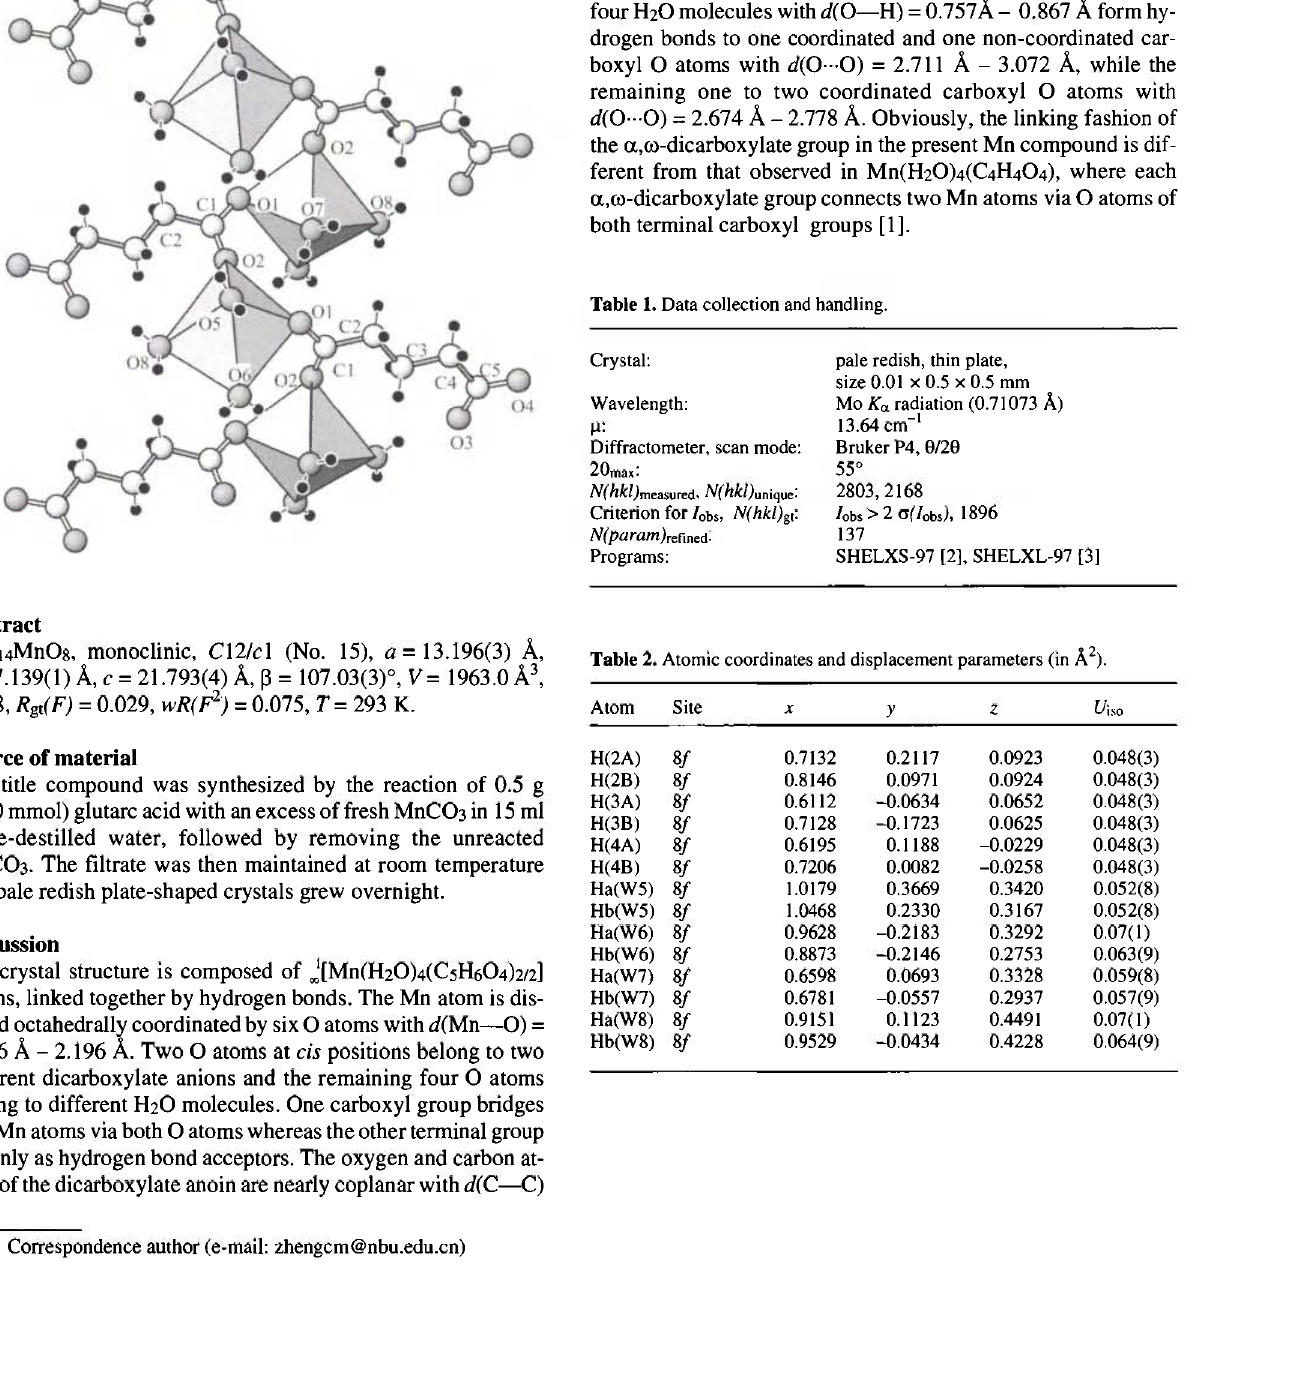
Table 1. Data collection and handling.